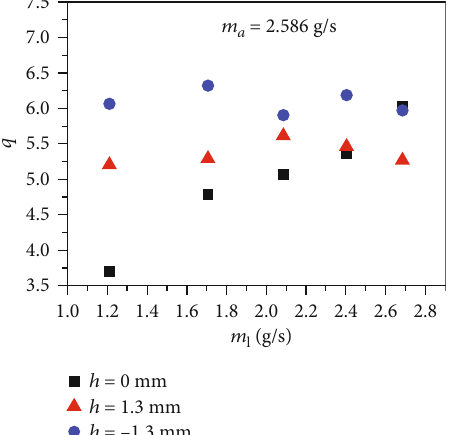
Figure 17: The droplet size distribution parameter q of h series nozzle with various mass fl ow rate of fuel at air mass fl ow rate of ma